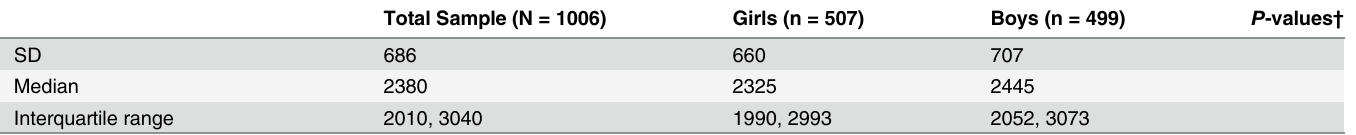
† — Values based on independent t-tests statistics for continuous variables and chi-Square Statistics for categorical variables; * — Signi fi cant difference between samples ( p < 0.05); PA — Physical Activity;